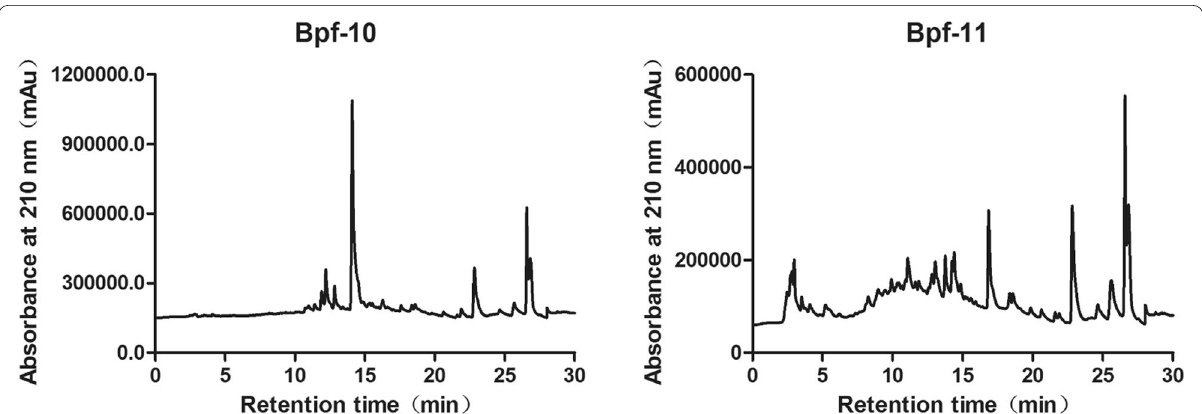
Fig. 3 HPLC-UV chromatograms of crude extracts of endophytes Bpf-10 and Bpf-11 at 210